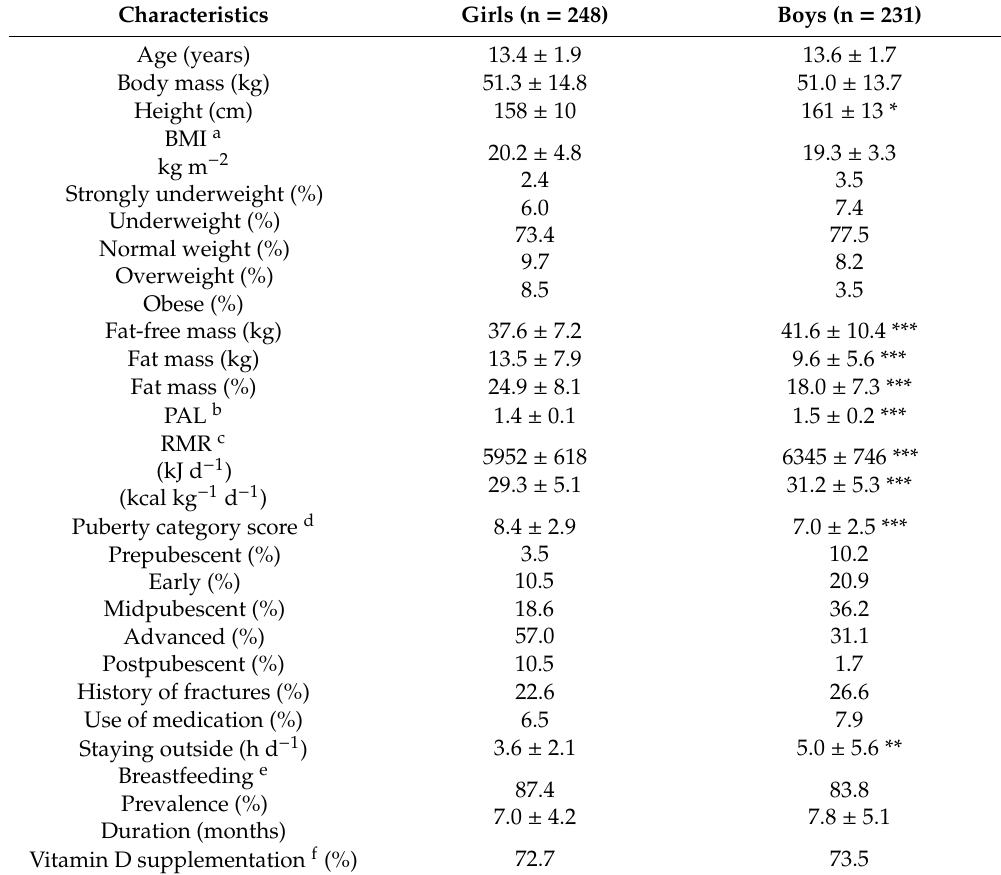
Table 2. Characteristics of the study volunteers. Data are presented as Mean ± SD and